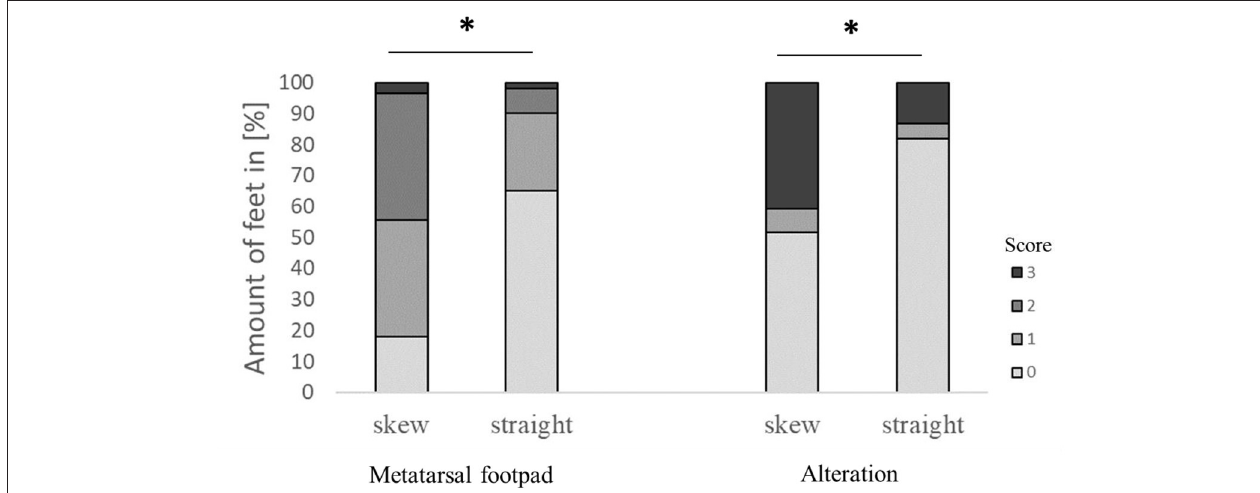
FIGURE 3 | Effect of the angle the foot was presented to the camera on the performance in detecting the metatarsal footpad and the alteration. Data are presented as the number of feet in percent for the respective scores with increasing gray levels indicating an increasing score level (light gray = scoring level 0–dark gray scoring level 3; see Table 2 for the explanation of scoring levels); * p < 0.05; the number of feet for the detection of the metatarsal footpad: skew = 2,008, straight = 3,127; the number of feet for the detection of the alteration: skew = 1,996, straight = 3,119.